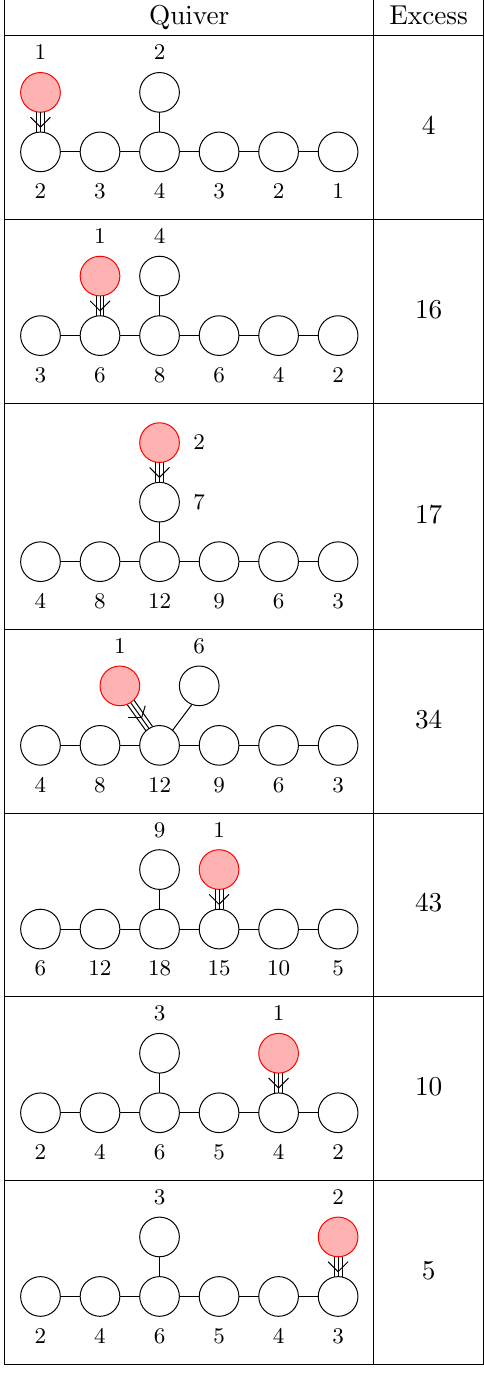
Table 22 . Exotic minimally unbalanced quivers of E 7 -type with outward triple laced